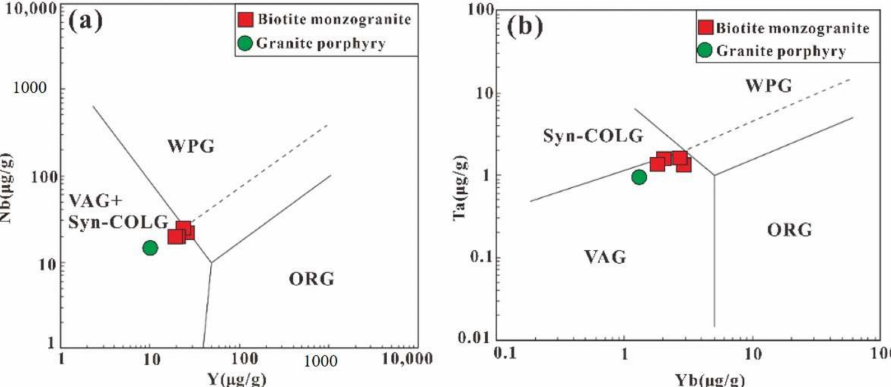
Figure 11. Discrimination diagram of the granite tectonic environment. Nb vs. Y diagram ( a ) and Ta vs. Yb diagram ( b ). Diagrams after Pearce et al. [42]). Fields for syncollision (COLG), volcanic-arc (VAG), within0plate (WPG), and ocean-ridge (ORG) granites are